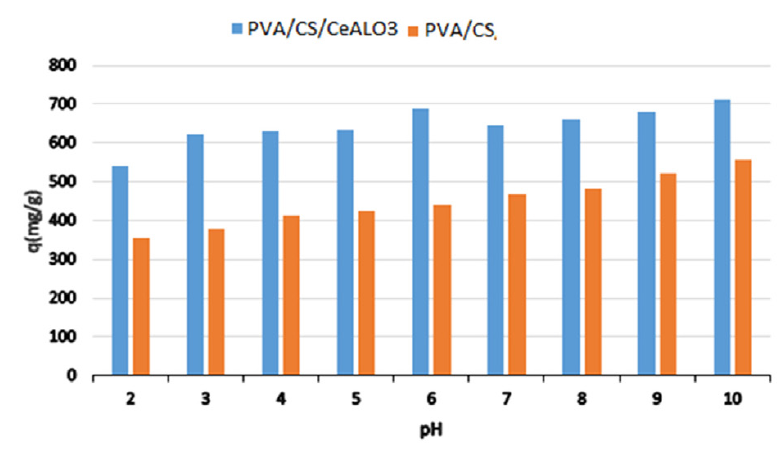
Fig. 8. Effect of pH on sorption of MB onto PVA/CS and PVA/CS/ CeAlO